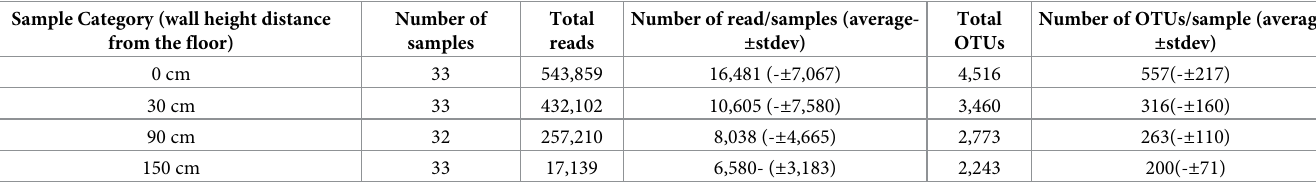
Summary statistics of the 16S rRNA genes bacterial reads across the 131 samples organized by sample category (wall height). The number of samples, total reads, total OTUs, by sampling category (sampling height) are provided. The average number of reads and OTUs per sample/category are also provided. Both total number of 16S rRNA bacterial reads and the total number of OTUs decrease importantly with sampling